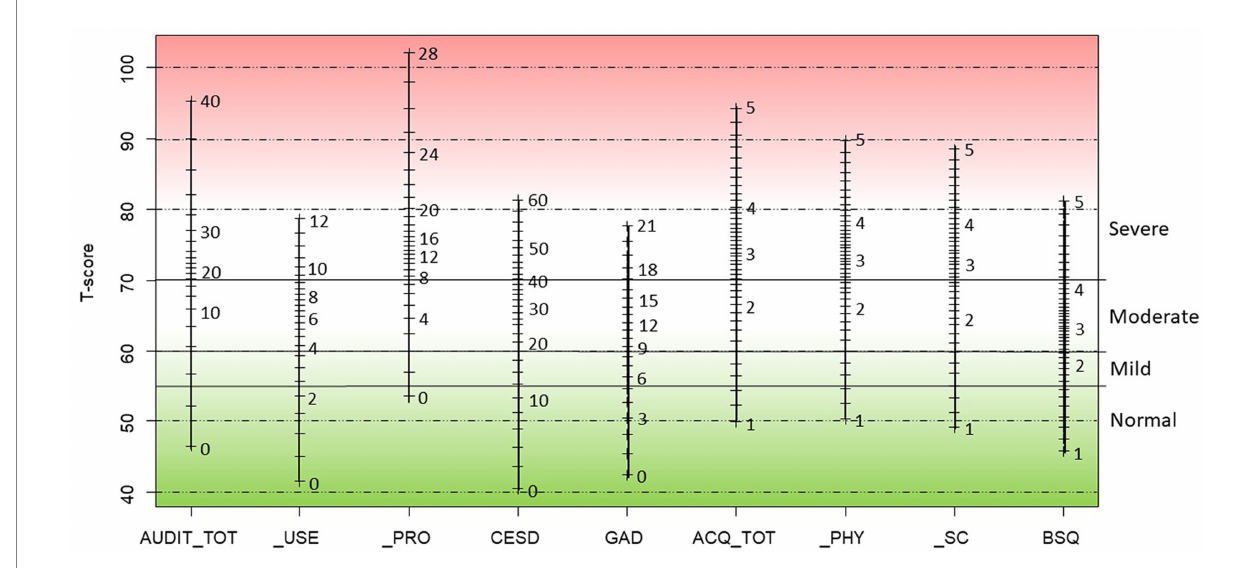
FIGURE 1 Crosswalk from raw scale scores to T-scores for the AUDIT, CES-D, GAD-7, ACQ, and